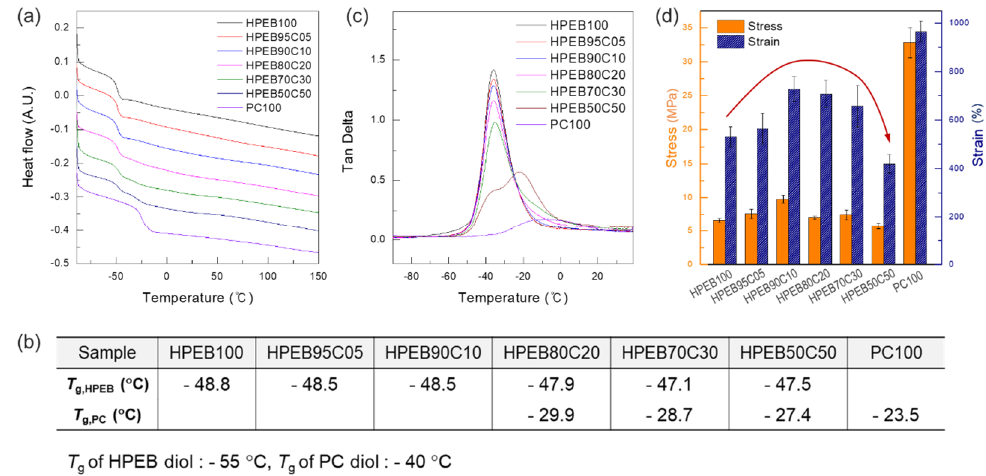
Figure 3. ( a ) DSC thermograms, ( b ) T g values measured by DSC, ( c ) Tan δ plots measured by DMA and ( d ) tensile stress and strain values of the polyurethane copolymers.